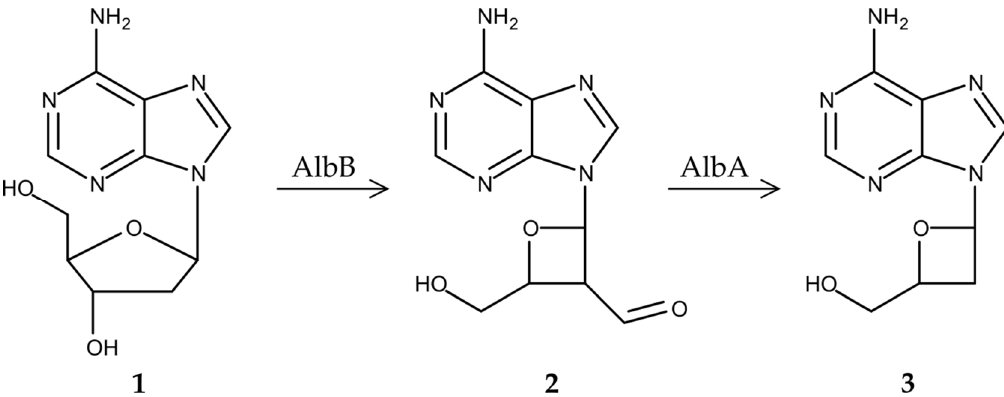
Figure 3. The proposed scheme of albucidin biosynthesis. 2’-Deoxyadenosine ( 1 ) is converted into the aldehyde form of oxetanocin A ( 2 ) by the product of albB . The latter is then converted into albucidin ( 3 ) by the product of albA .